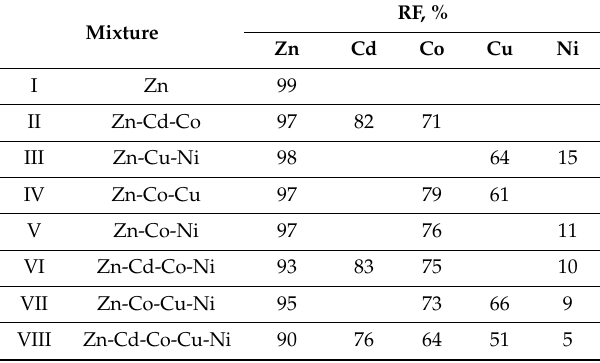
Table 4. Recovery factor for Zn(II), Cd(II), Co(II), Cu(II), and Ni(II) ions from ammonia solutions (pH = 7.8) after 12-h transport across PIMs with